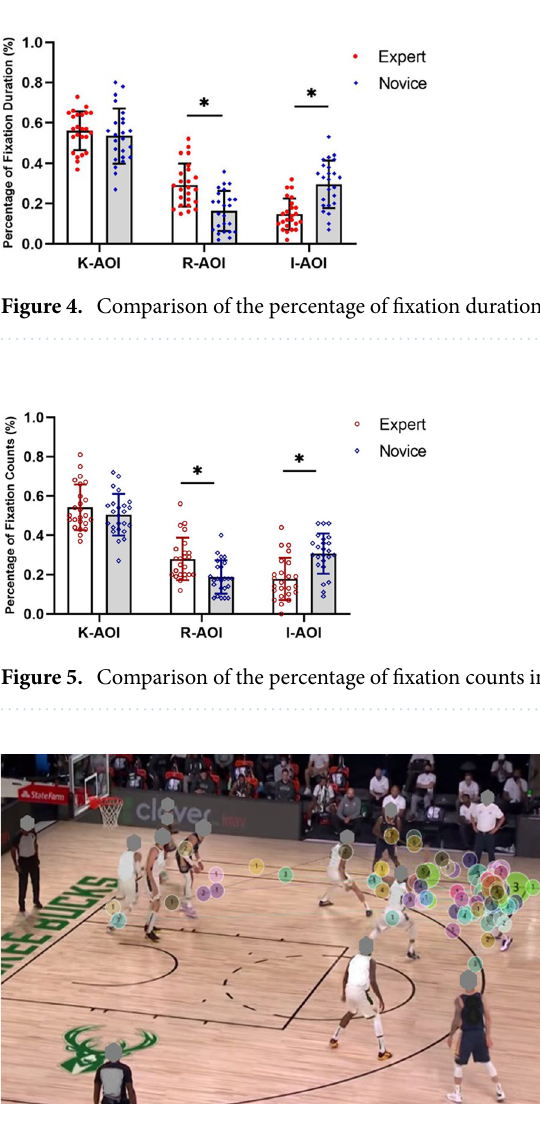
Figure 6. Aggregated Gaze Plot for experts.